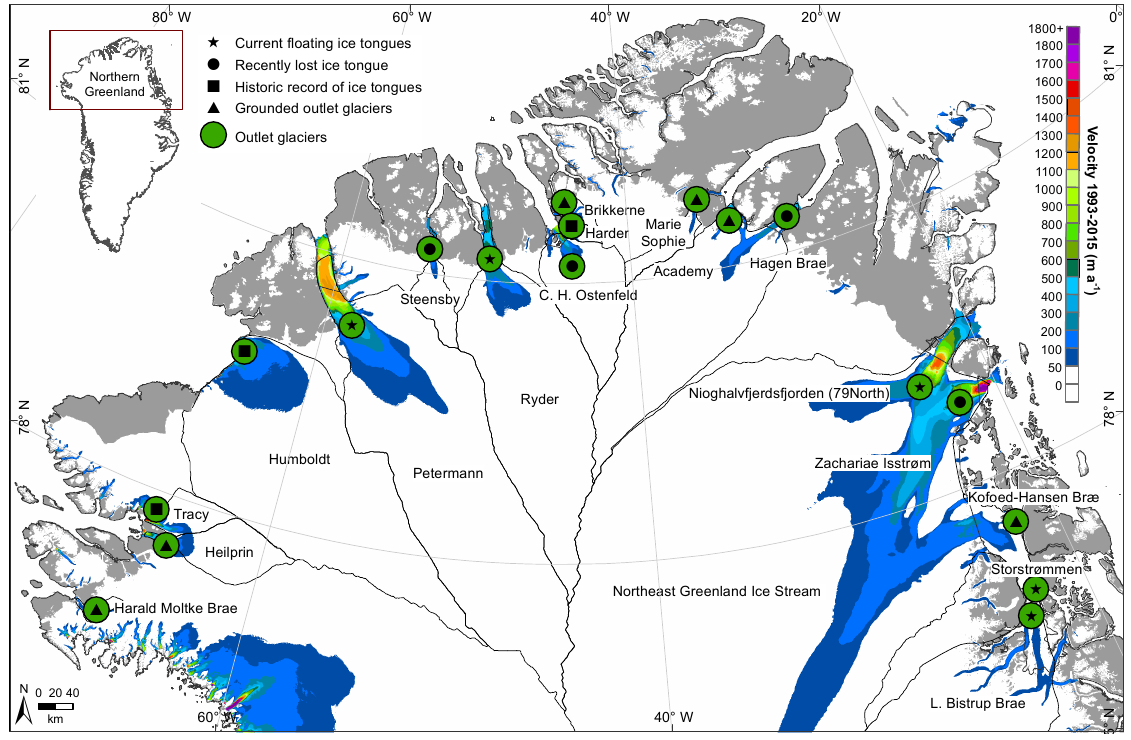
Figure 1. Study region of northern Greenland. Green circles show the location of each of 18 northern Greenland study outlet glaciers. Average glacier velocities (ma − 1 ) are shown between 1993 and 2015 derived from the multi-year mosaic dataset (Joughin et al., 2010). Black outlines show glacier drainage catchments. Symbols represents the state of the glacier terminus. Stars show glaciers which currently have floating ice tongues, circles represent glaciers which lost their ice tongues (during 1995 to 2015), squares denote glaciers which have some previous literature record of a floating ice tongue, and triangles are glaciers which are grounded at their termini and have been throughout the study